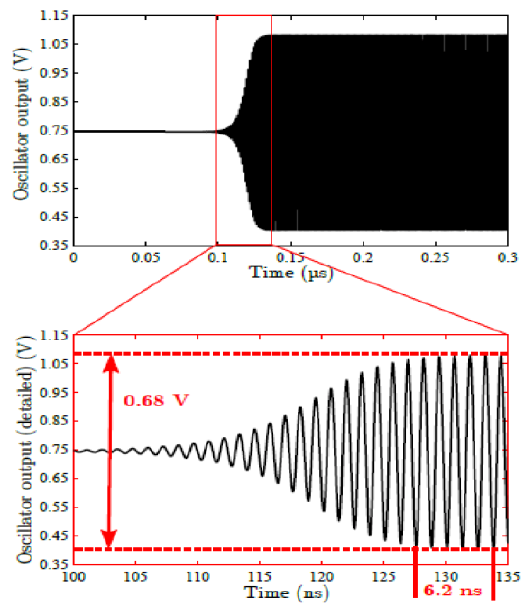
Figure 4. Simulated transient characteristic of the Colpitts oscillator.